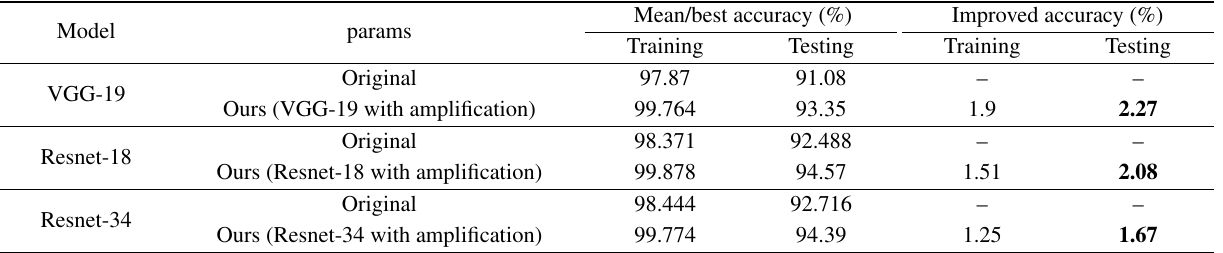
Table 1 Accuracy comparison of models with gradient amplification vs. mean accuracies of corresponding original model across 5